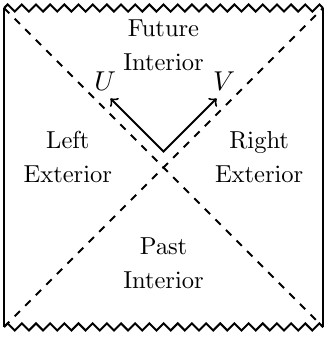
Figure 1 . Penrose diagram for the two-sided black branes we